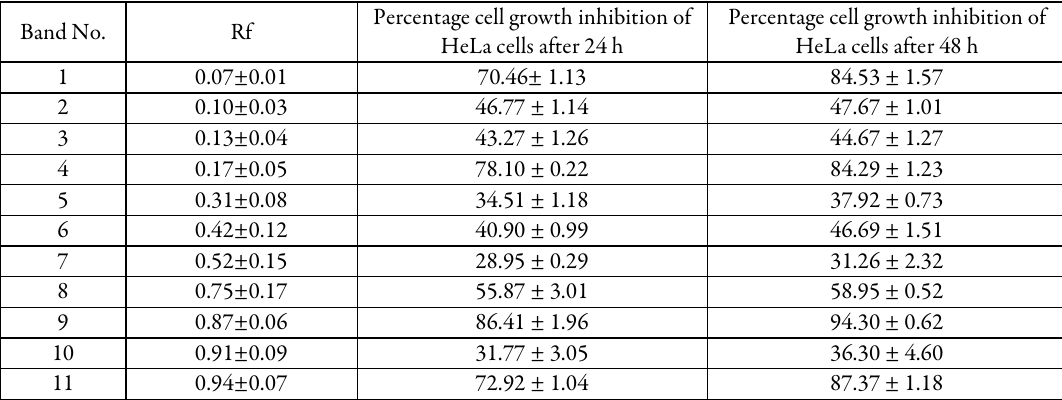
Table 2. Rf value and cytotoxicity of compounds eluted from TLC bands of R-Ac extract (100 μL/mL) of